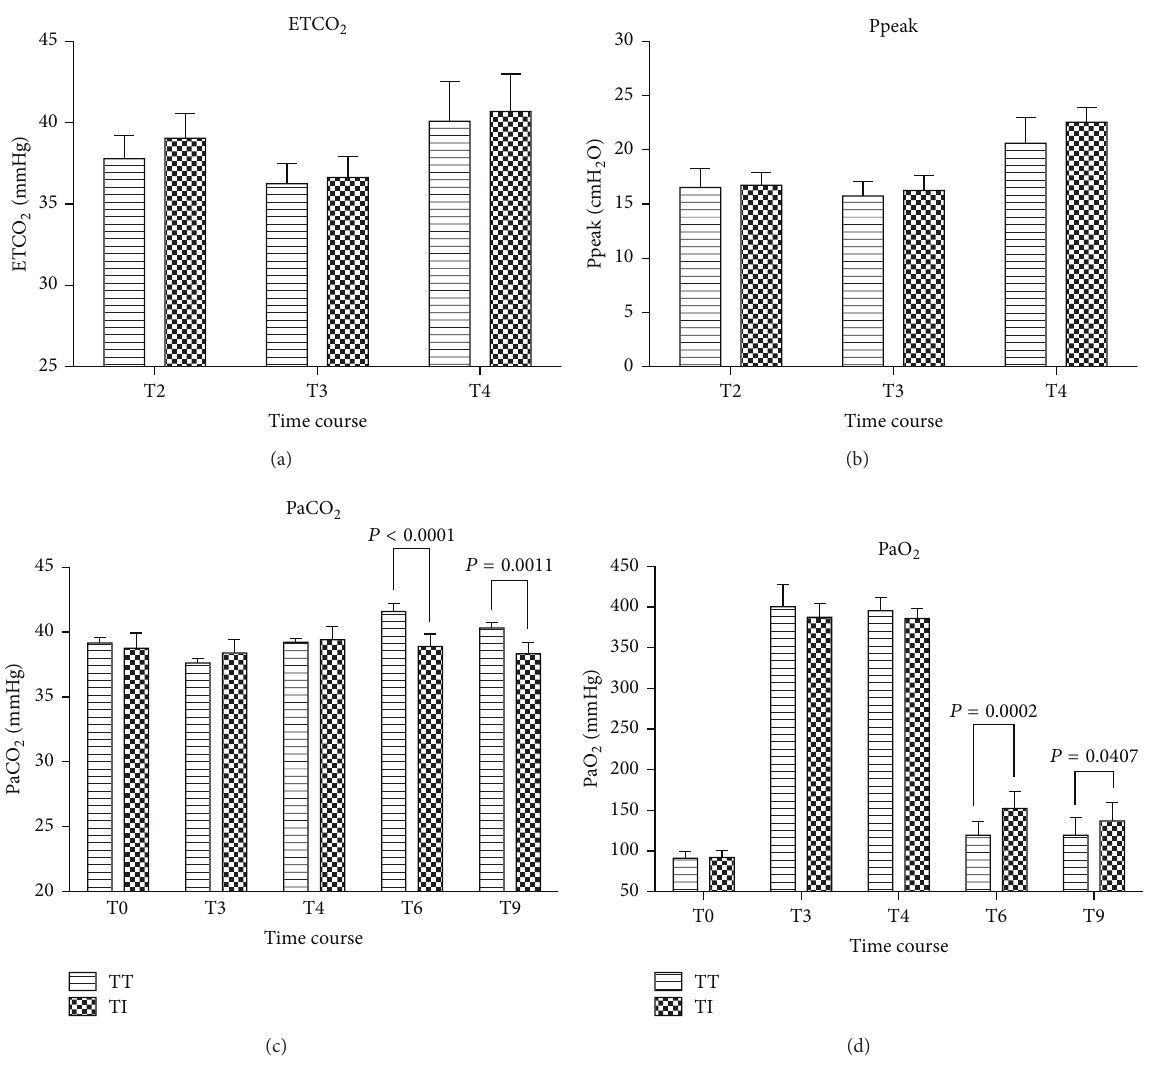
Figure 3: Changes in ETCO 2 , Ppeak, PaCO 2 , and PaO 2 in patients with a tracheal tube intubation (Group TT) or an I-gel facilitated endotracheal tube intubation (Group TI) over a period of time. Results are expressed as Mean ± SD. No significant difference in ETCO 2 and Ppeak over time. During emergence, PaCO 2 and PaO 2 were better in Group TI than those in Group TI, and the differences were significant. Baseline (T0); endotracheal tube intubation (T2); 3 min after intubation (T3); end of surgery but before awakening (Group TT) or before endotracheal tube removed (Group TI) (T4); and throughout emergence from anesthesia at 1 and 30 minutes after extubation or I-gel removal (according to group assignment) (T6, 9).